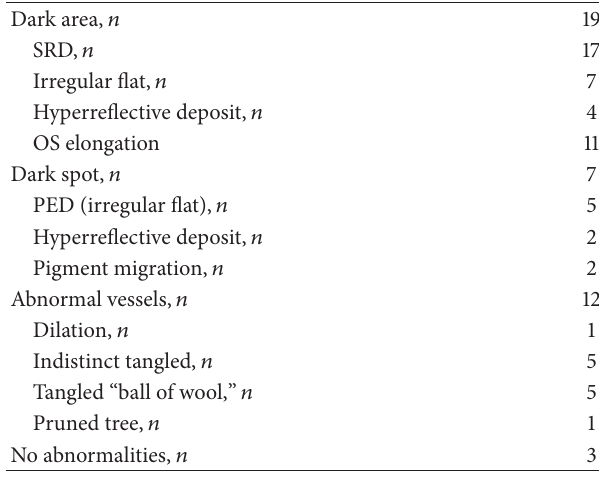
Table 1: Main demographical and clinical findings of study patients. Patient, 𝑛